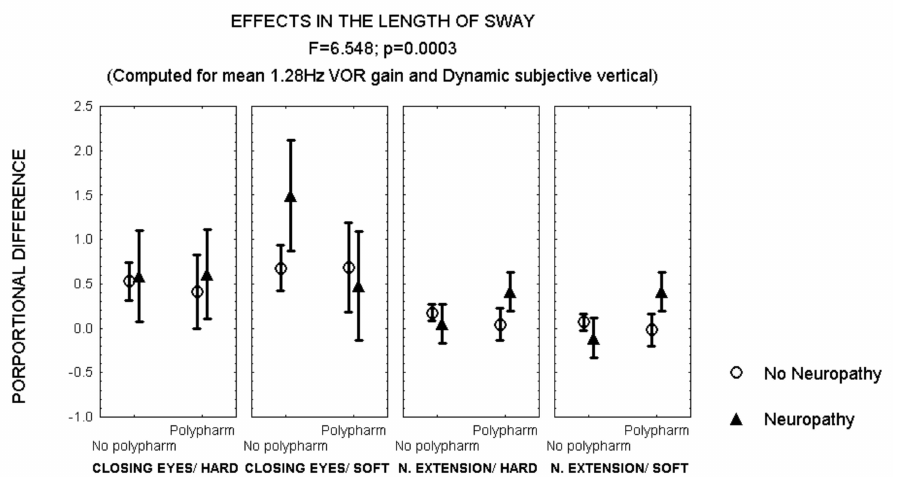
Figure 4. Mean and standard error of the mean of the proportional difference in the length of sway after closing the eyes or extending the neck, while standing either on hard or soft surface, according to polypharmacy and the evidence of polyneuropathy. Statistical significance is provided according to the overall result of the analysis by MANCOVA, including the variables described in the Figure.